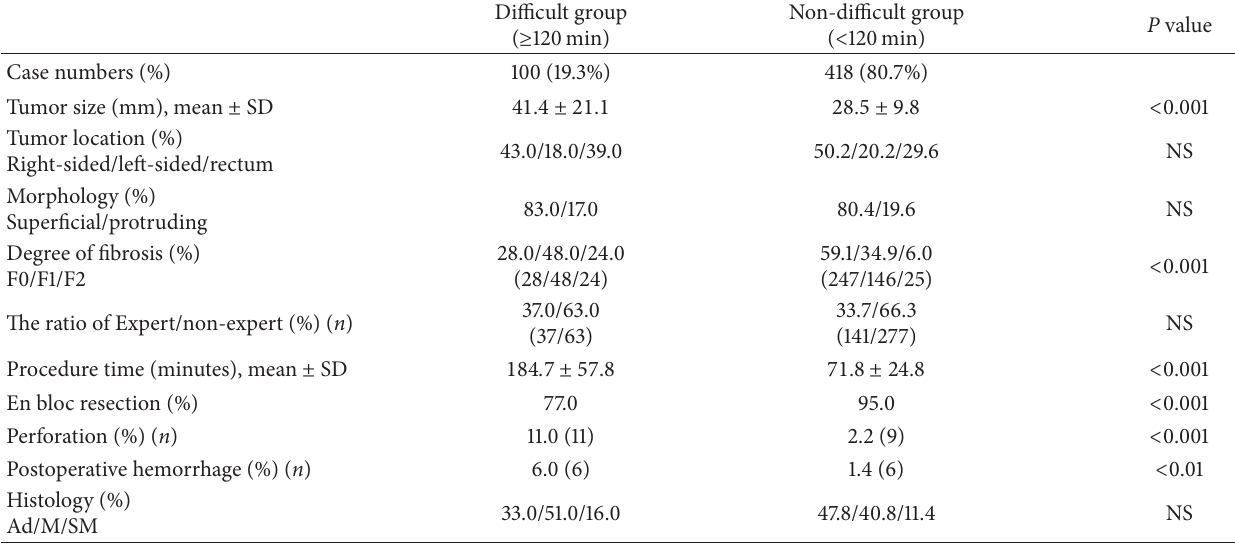
Table 2: Clinical outcomes of difficult and non-difficult groups in view of procedure